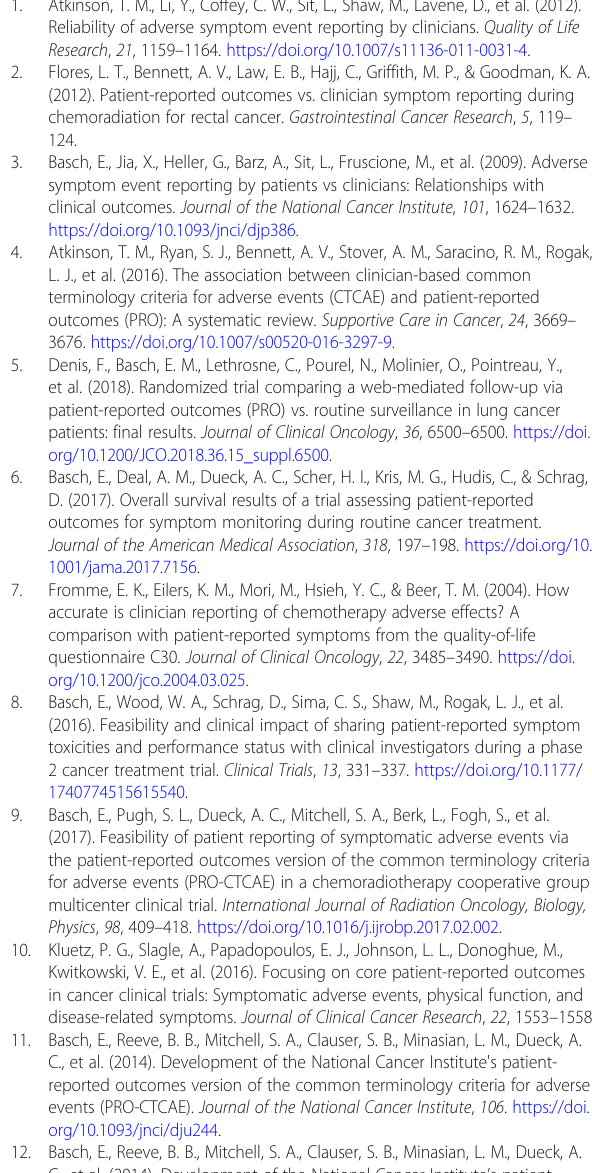
Additional file 1 Table S1 . Frequency table of participants debriefed by PRO-CTCAE symptom term and proportions endorsing difficulties with comprehension or judgement in Round